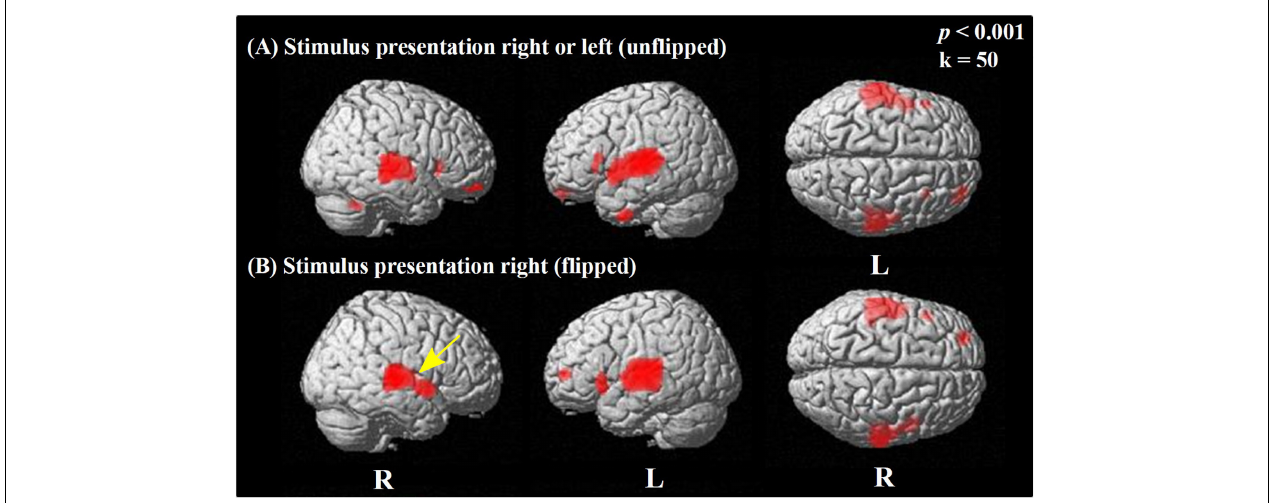
FIGURE 2 | Statistical parametric maps (SPMs) reflecting relative increases of perfusion due to performing the speech condition in comparison to the rest condition. SPMs are overlaid to a surface rendered MRI data set in the Montreal Neurological Institute (MNI) space. There are some areas displayed more transparent than others, which refers to their distance to the projection surface. (A) The results obtained using the original data without left/right flipping are displayed. (B) To explore for potential effects of the side of stimulation, each data set with left-sided stimulation was flipped in the median sagittal plane, while data sets with right-sided presentations remained unflipped. This resulted uniformly in data sets with stimulation from the “right” side in relation to the images for analysis. For both comparisons, the contrast speech condition > rest condition is displayed. Strong significant perfusion increases due to the task are similarly visible in (A,B) , showing bilateral activation in the superior and middle temporal cortices and the inferior prefrontal cortex. Note the minor difference between unflipped and flipped images, with a lack of perfusion increase in the ipsilateral (right) primary auditory cortex (BA 41; yellow arrow) for the flipped in contrast to the unflipped image (see also Supplementary Table A.2 ).